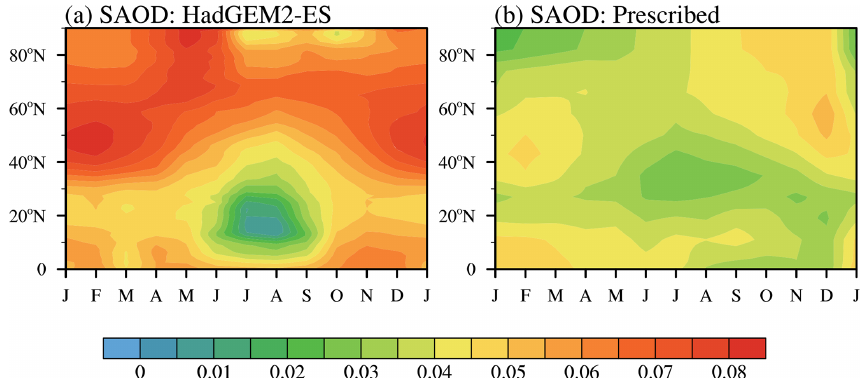
Figure 10. Latitudinal distributions of the calculated ( a ; for HadGEM2-ES) and prescribed ( b ; for BNU-ESM, CNRM-ESM1, and the MIROC-based models) changes in SAOD at 550nm caused by SAI in G4 experiment over the Northern Hemisphere during the period of